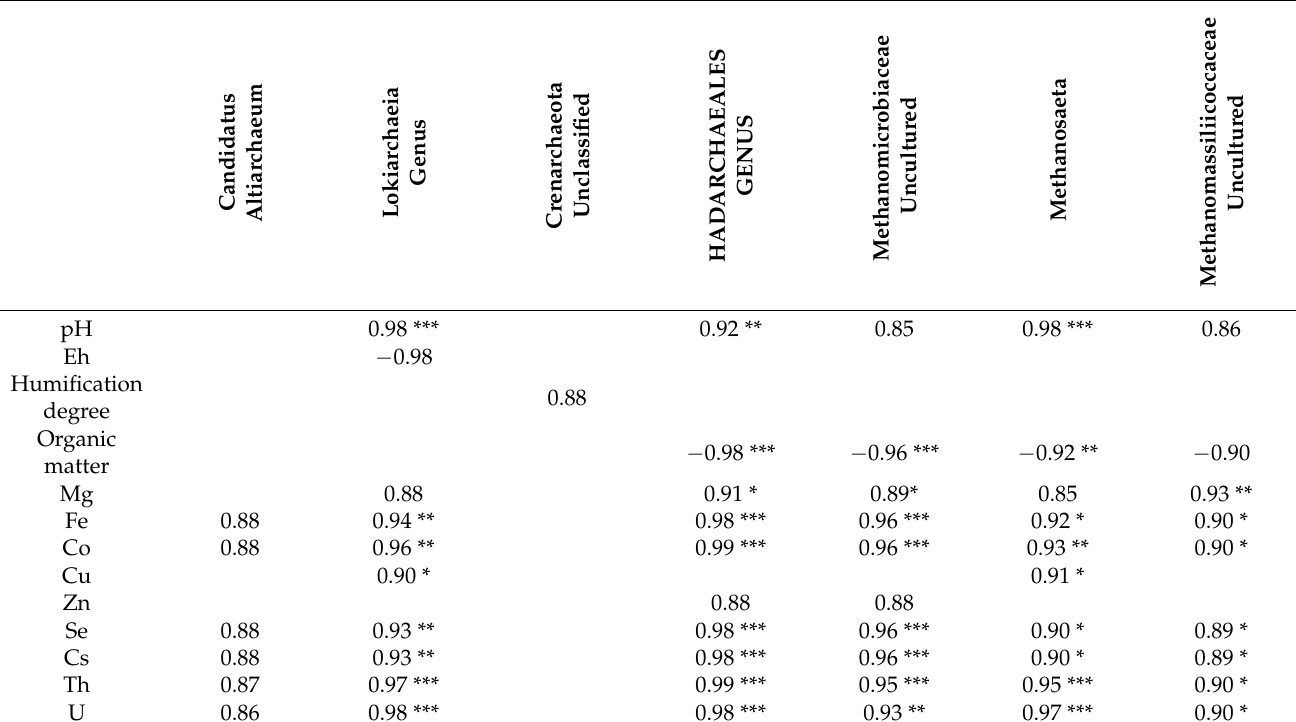
Figure A7. The relative abundance of Chloroflexi genera in Lastensuo Bog samples. Table A1. Pearson correlation coefficients of the Bonferroni corrected correlations between relative abundance of archaeal genera and physicochemical parameters and metal concentrations. Correlation coefficients for pairs with p < 0.05 are